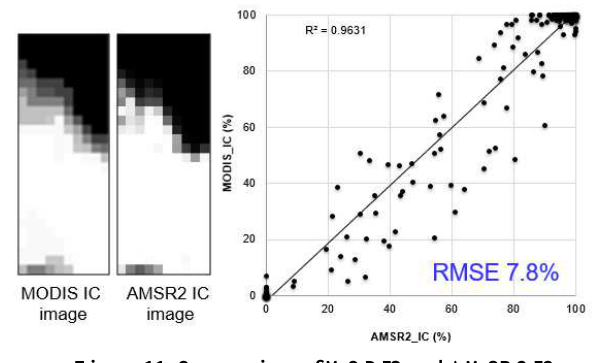
Figure 11. Comparison of MODIS and AMSR2 IC (Southern Sea, December, 11, 2016) Table 3. Validation result of AMSR2 sea